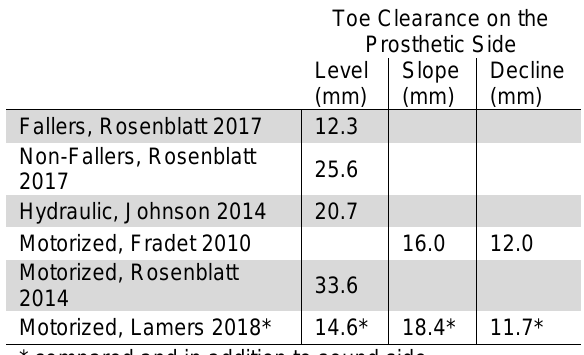
Table 1: Comparison of prosthetic side toe clearances in mm.